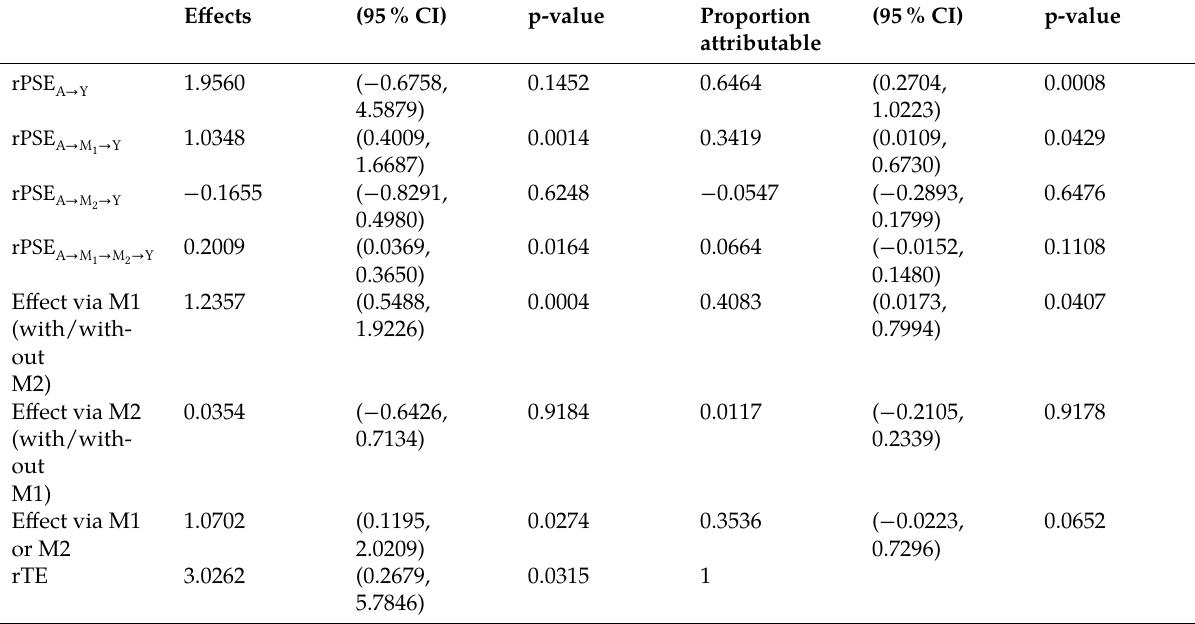
Table 1: Proportions of the effect of smoking on systolic blood pressure mediated by cholesterol and/or body mass